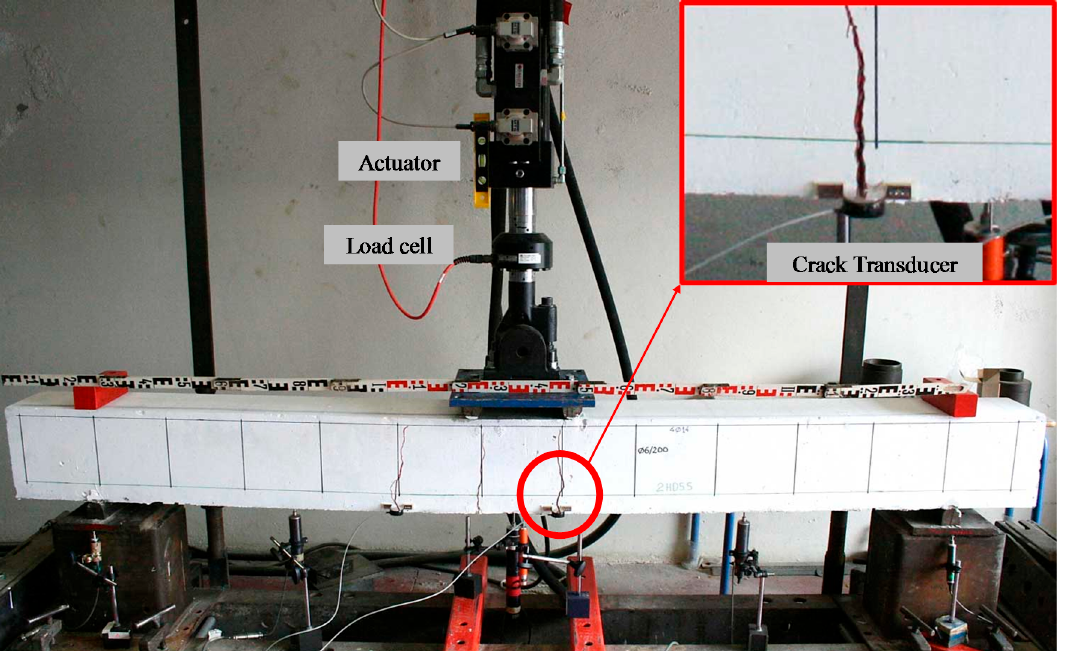
Figure 3. Experimental setup and instrumentation (specimen BF5-0).